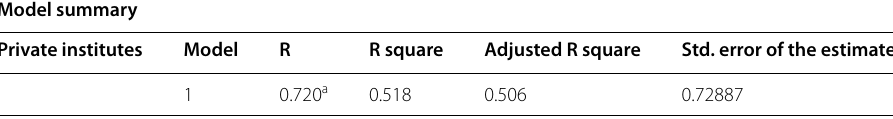
a Predictors: (constant), CE, Grit